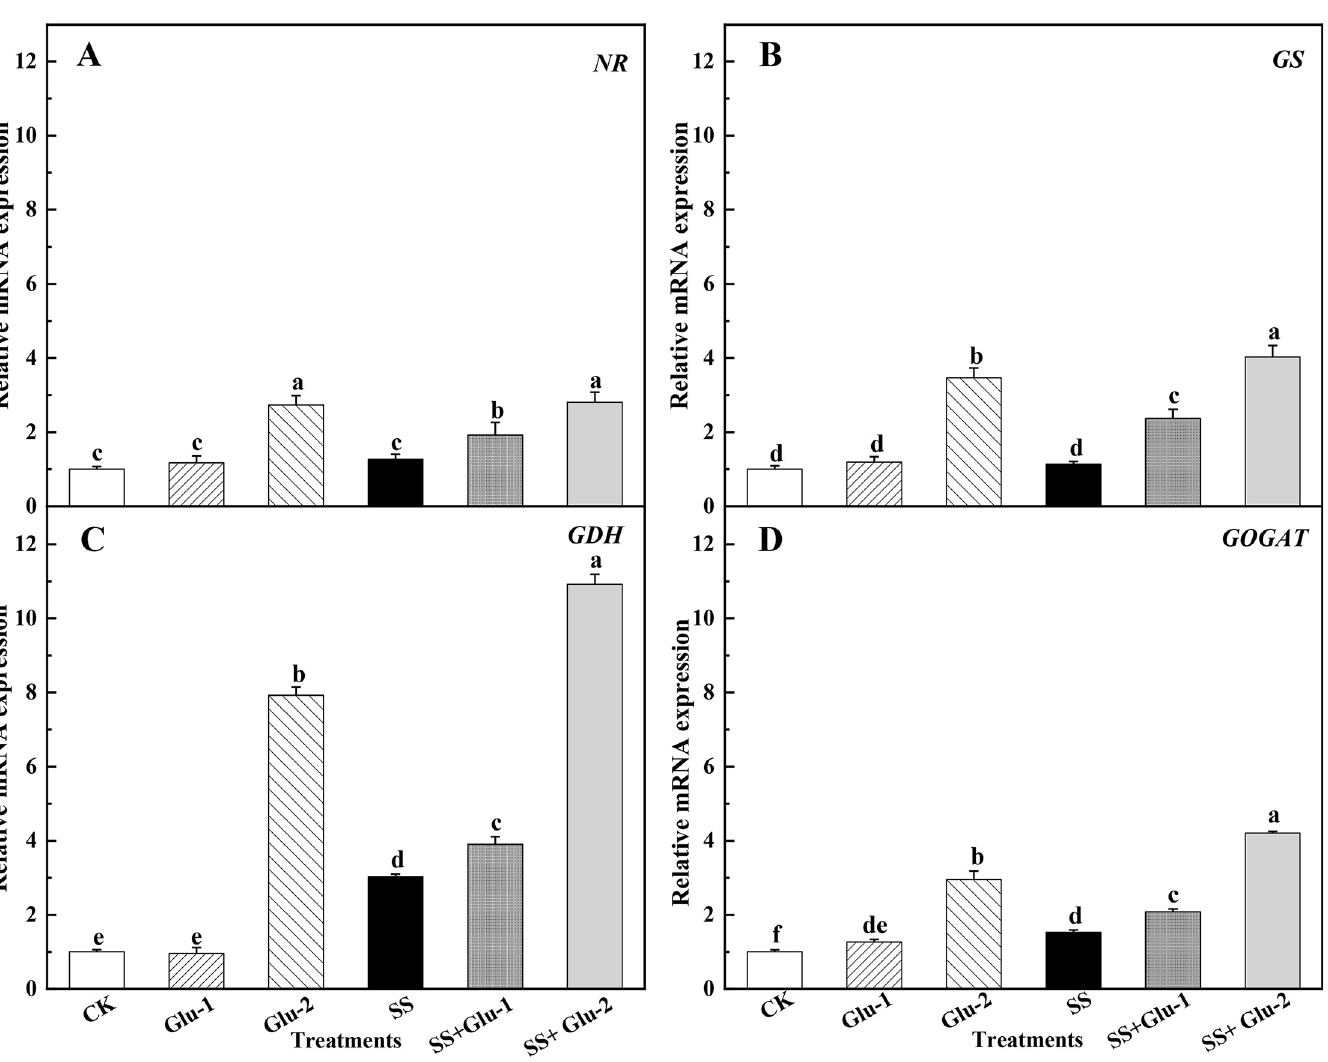
Fig 6. The transcript levels of genes involved in N metabolism of root in the sterilized and non-sterilized soils with glucose addition at day 45. NR (A), GS (B), GDH (C) and GOGAT (D). Different lowercase letters indicate significant differences between treatments ( P < 0.05). CK, non-sterilized soil without glucose addition; Glu-1, non- sterilized soil with low level of glucose addition; Glu-2, non-sterilized soil with high level of glucose addition; SS, sterilized soil without glucose addition; SS+Glu-1, sterilized soil with low level of glucose; SS+Glu-2, sterilized soil sterilization with high level of glucose